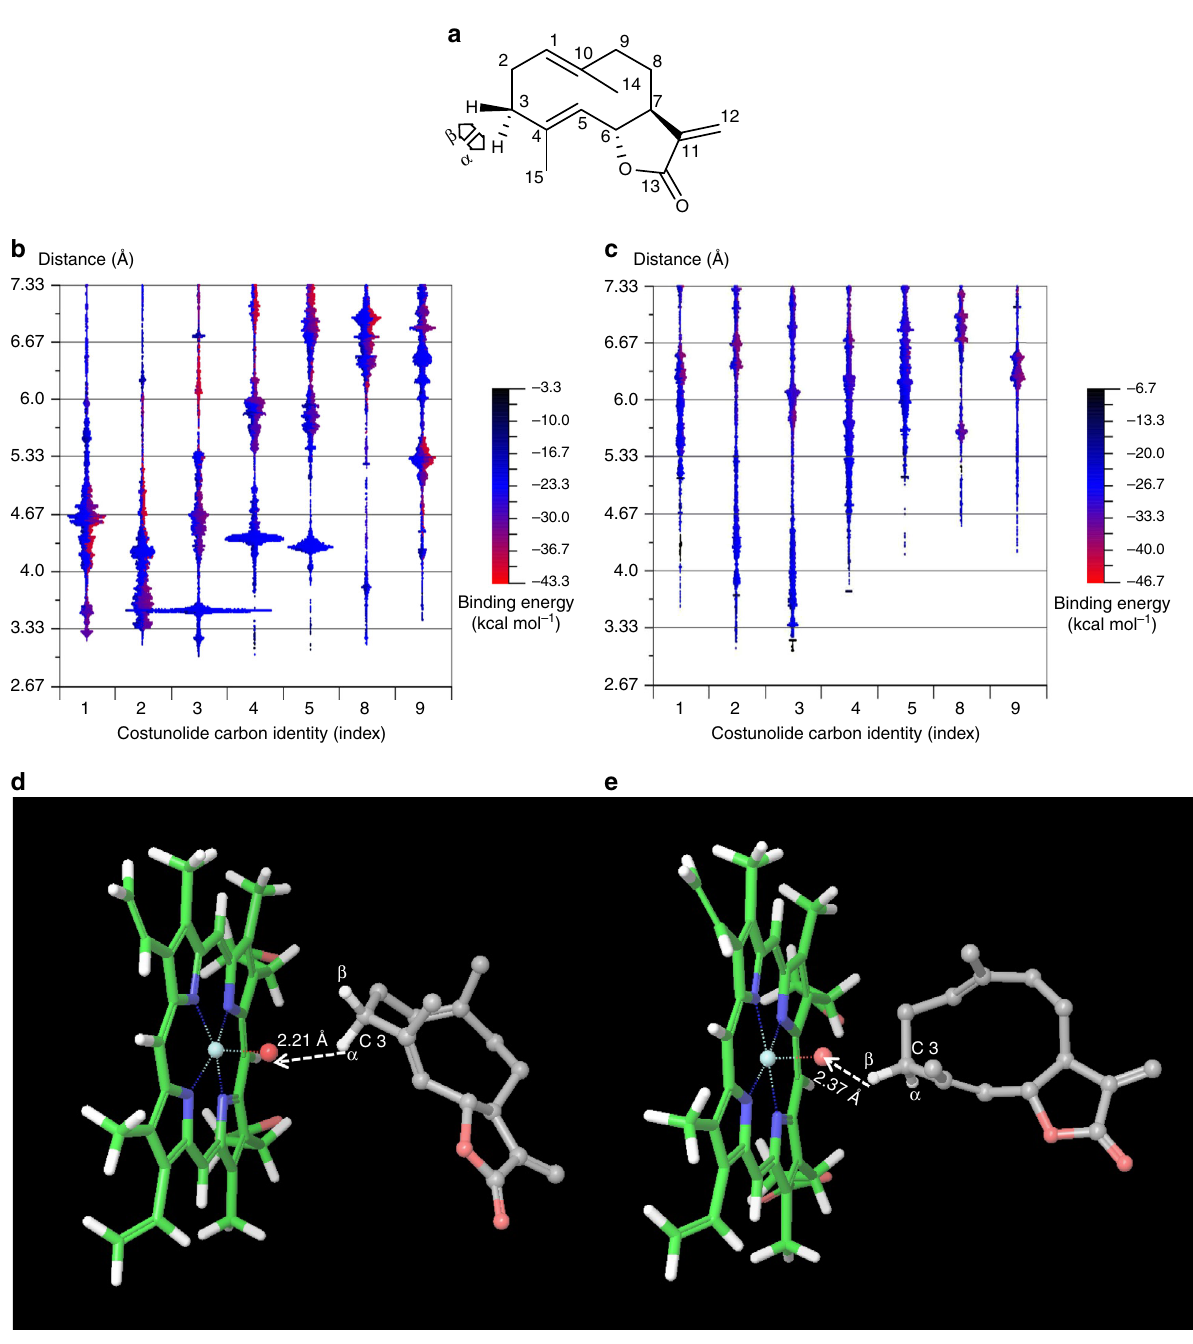
Fig. 3 In silico docking of costunolide into the active site of the feverfew enzymes, kauniolide synthase and costunolide 3 β -hydroxylase. a Structure of costunolide and pro- α and pro- β hydroxylation orientations. b Preferred docking orientations of costunolide as calculated using Protein Energy Landscape Exploration software. Costunolide carbon distance distribution relative to the haem oxyanion in a KLS homology model (constrained model, at 15 Å). c Costunolide carbon distance distribution relative to the haem oxyanion in a costunolide 3 β -hydroxylase homology model (constrained model, at 15 Å). In silico docking of costunolide into the active site of kauniolide synthase and costunolide 3 β -hydroxylase by Glide. d Preferred docking of costunolide in the active site of kauniolide synthase is in α -orientation. e Preferred docking of costunolide in the active site of costunolide 3 β -hydroxylase is in β -orientation. Colour keys of b , c represent the binding energy (kcal mol − 1 ) expressed in negative